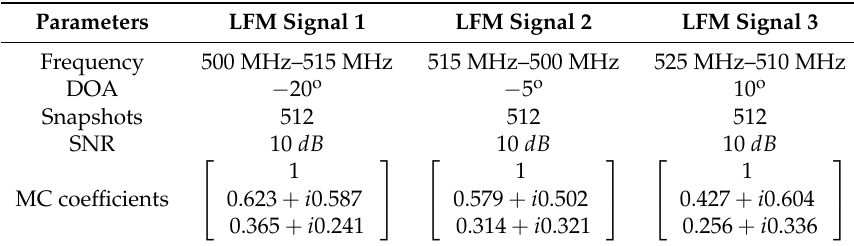
Table 2. Parameters of Linear Frequency Modulation